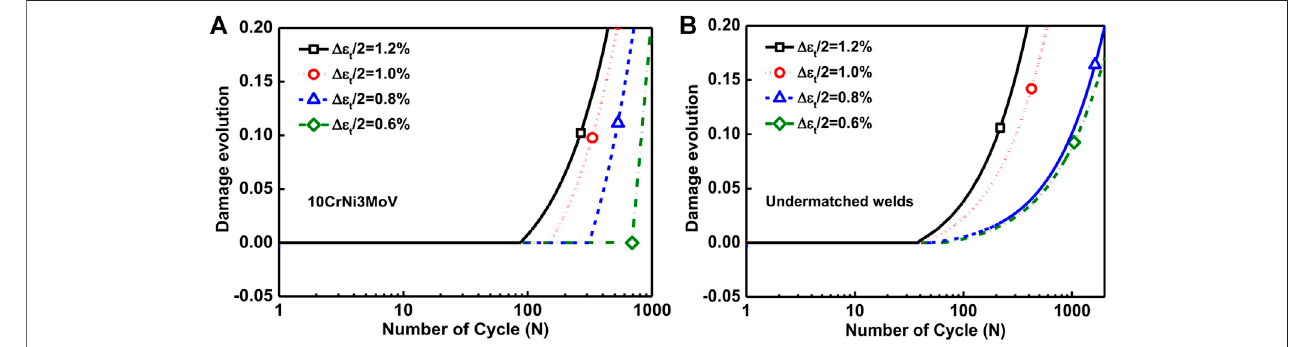
FIGURE 15 | Simulation damage evolution under different strain amplitudes. (A) Base metal and (B) undermatched welds.